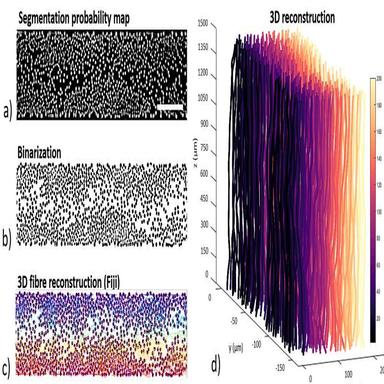
Workflow for image analysis and fibre path reconstruction, based on Tape A a) Image segmentation, conducted with Trainable Weka segmentation. The scalebar in white indicates a distance of 100 μm b) Image binarization via thresholding c) fibre path reconstruction using Trackmate, colourcoded according to the average throughthickness position of the fibre paths d) 3D reconstructed fibres for a portion of the tape, colour-coded along the tape width direction. (For interpretation of the references to colour in